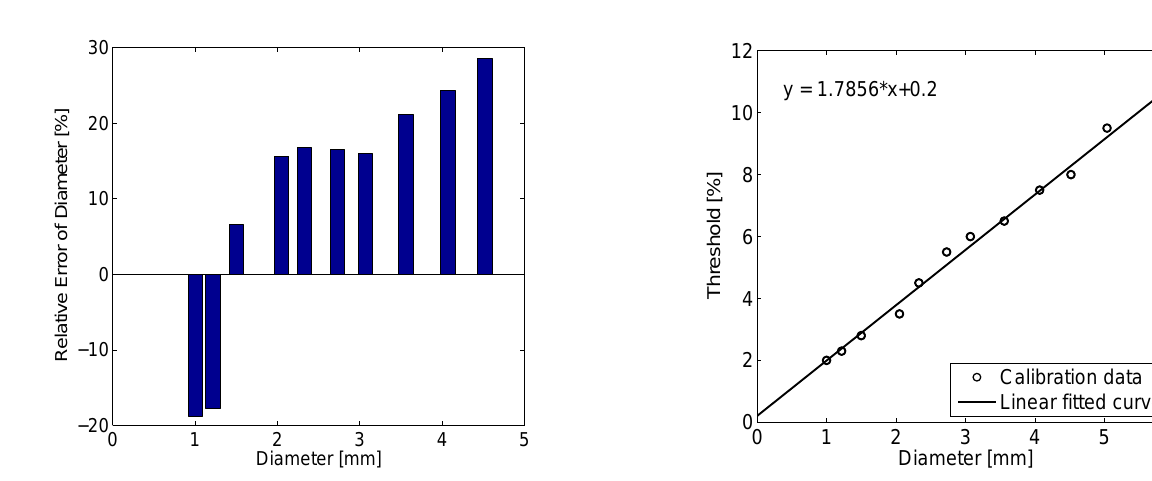
Figure 10. Calibrated binarization threshold for different diameters. 3